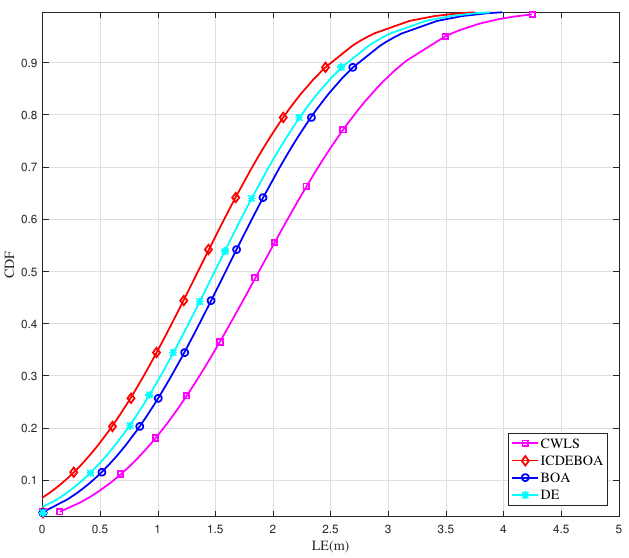
Figure 7. The obtained CDFs of LE for considered passive TDOA-based localization